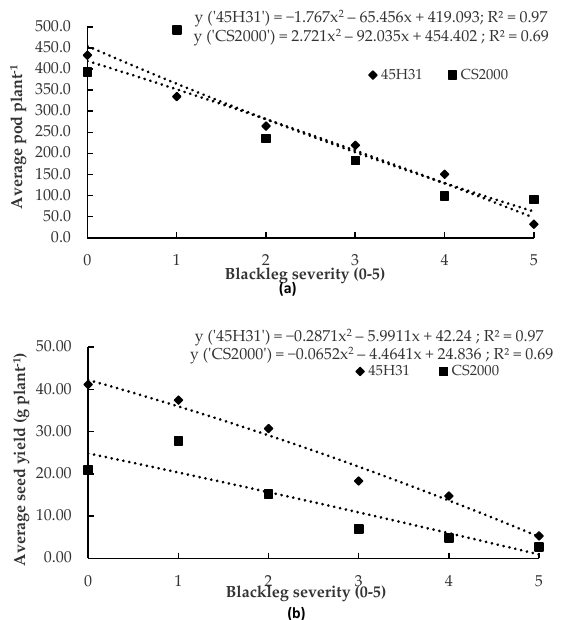
Figure 2. Relationship between blackleg severity and pods per plant ( a ) or seed yield per plant ( b ) in the canola hybrids ‘45H31’ and ‘CS2000’ under field conditions. Data were collected over two years (2019 and 2020) at two sites in Edmonton, AB, Canada. Each point represents the mean of four replications × two site-years. Blackleg severity was assessed on a 0–5 scale, where 0 = no disease and 5 = death of the plant.